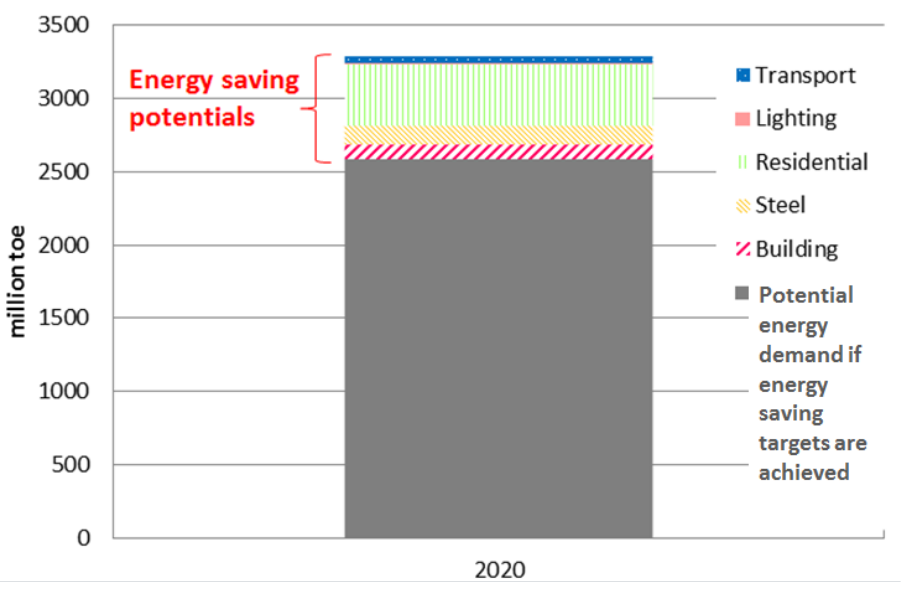
Figure 11. Energy saving potentials proposed by